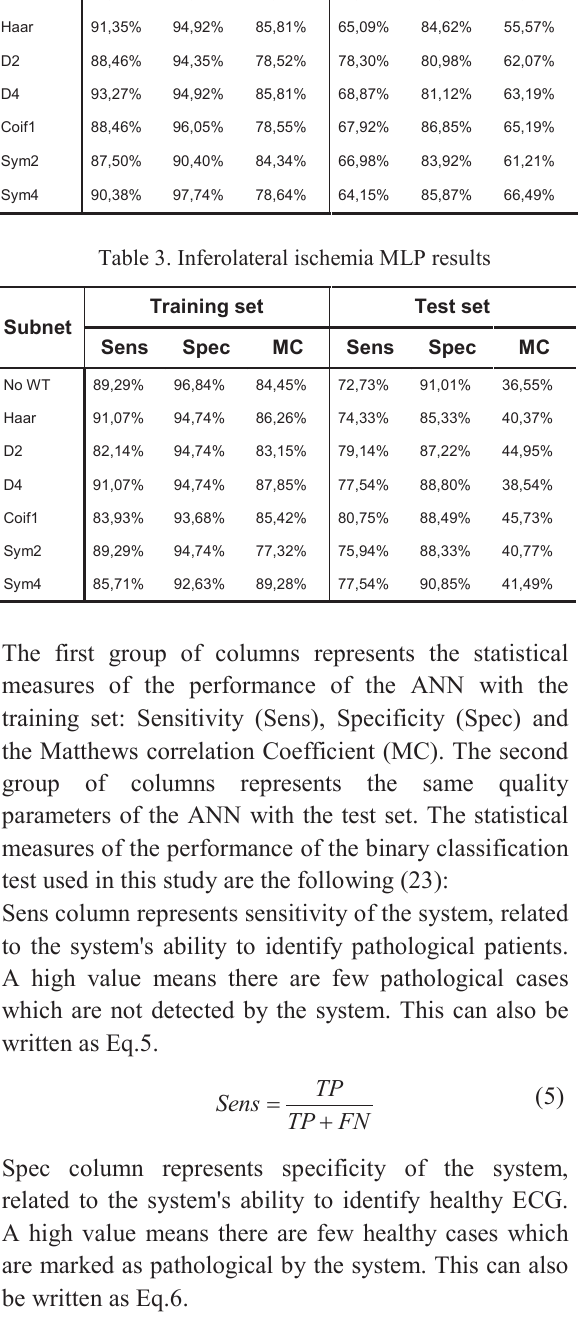
Table 2. Anteroposterior ischemia MLP results Training set Test set Subnet